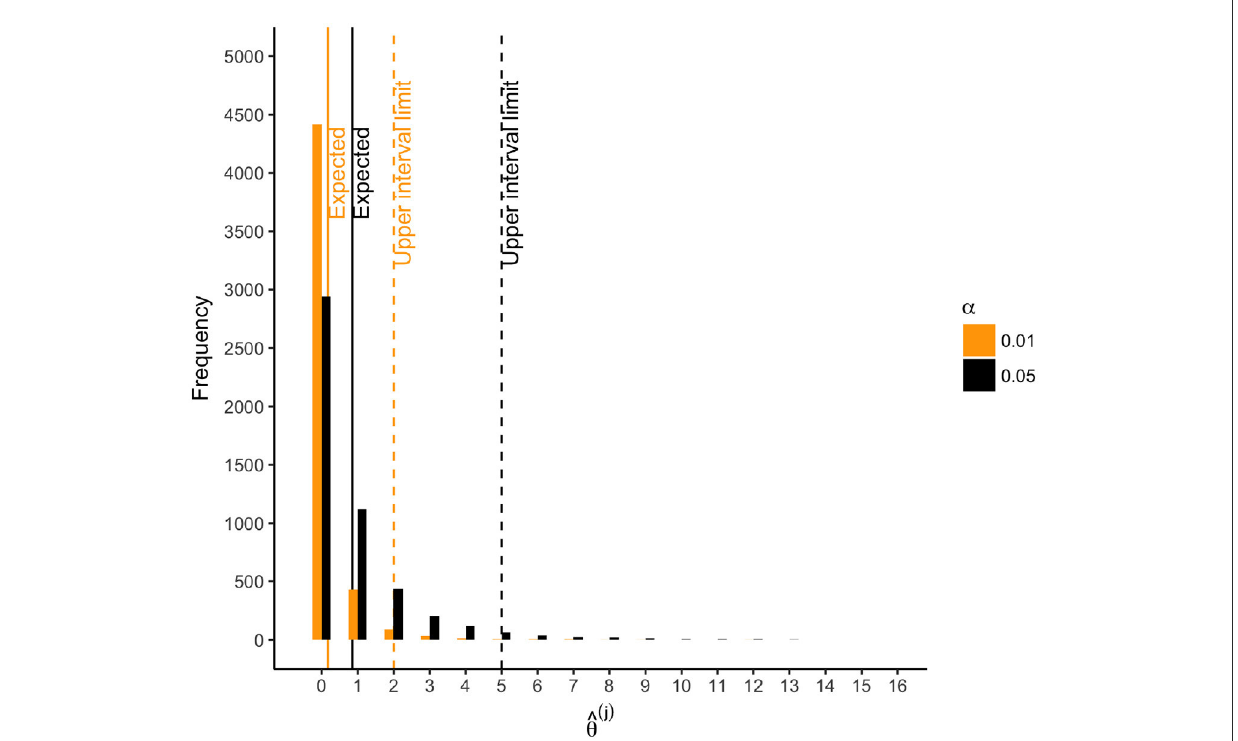
FIGURE7 For scenarios with 40 outcomes, number of rejections ( ˆ θ ( j ) ) for each of 5,000 resamples. Solid lines: E [ ˆ θ 0 ] = α × 17. Dashed lines: upper limit of 95% null interval.